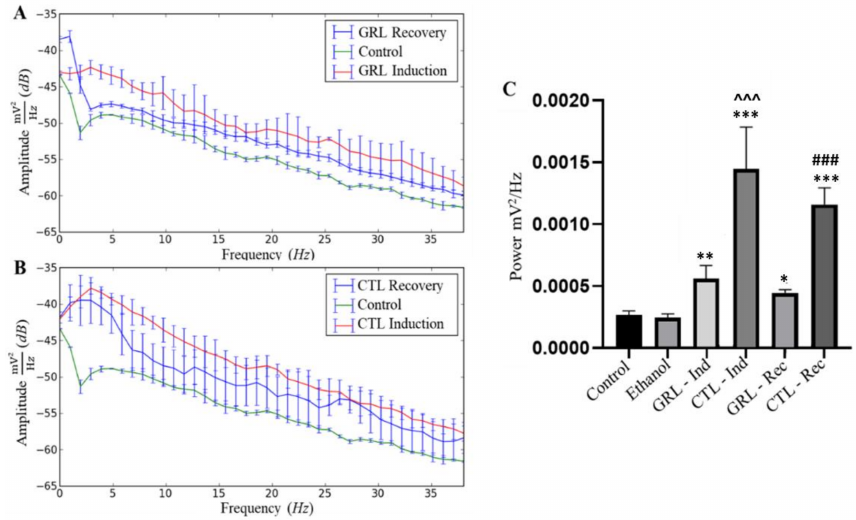
Figure 4. Power spectral density (PSD) of frequencies up to 40 Hz in juvenile tambaqui C. macropo- mum with comparisons among the control, during induction with geraniol (GRL—70 µ L · L − 1 ) and respective recovery ( A ); and during induction with citronellol (CTL—90 µ L · L − 1 ) and recovery ( B ). Differences in mean power among the control, ethanol, geraniol induction (GRL—Ind), citronellol induction (CTL—Ind), geraniol recovery (GRL—Rec), and citronellol recovery (CTL—Rec) groups are presented ( C ). * indicates statistical difference from the control group; ˆ indicates statistical difference from the GRL—Ind group; # indicates statistical differences from the GRL—Rec group (after ANOVA followed by Tukey’s test). The single * represents p < 0.05; Symbols in duplicate ** correspond to p < 0.001; Symbols in triplicate ***, ###, ˆˆˆ correspond to p < 0.0001, ( n = 9).